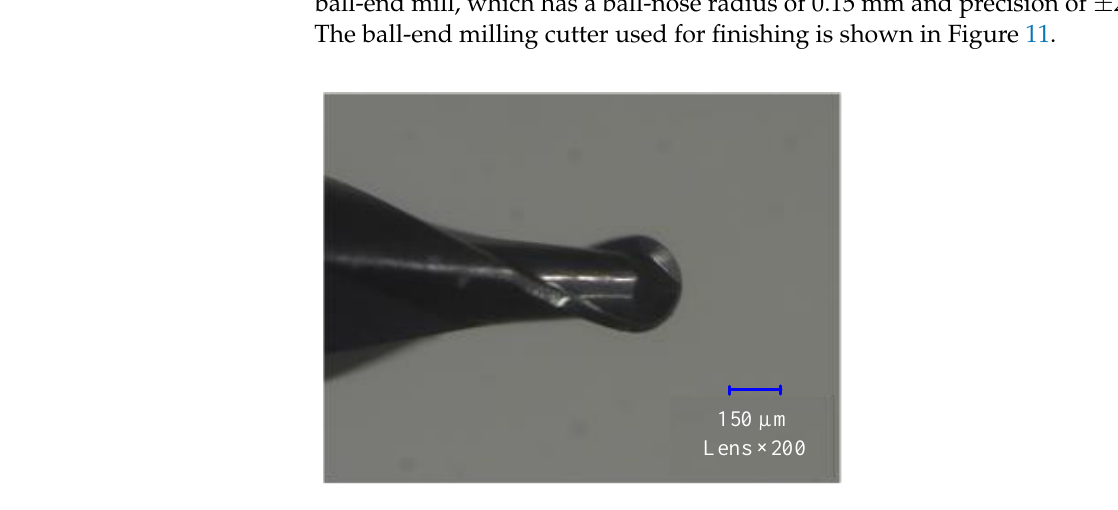
Figure 11. Micro ball-end milling cutter.